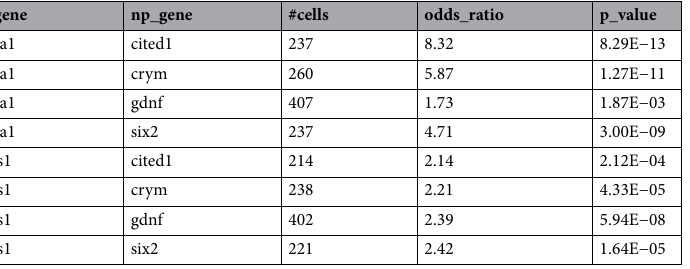
Table 1. Co-expression of stromal marker genes and nephron progenitor marker genes in cortical/stromal cells. The cs_gene and np_gene columns show the cortical/stromal and nephron-progenitor marker genes, respectively; the #cells column shows the number of cells expressing both genes in the stromal/cortical cluster (which contains 1,085 cells overall), while the odds_ratio and p_value columns contain odds ratio and p_value of a corresponding Fisher exact test.